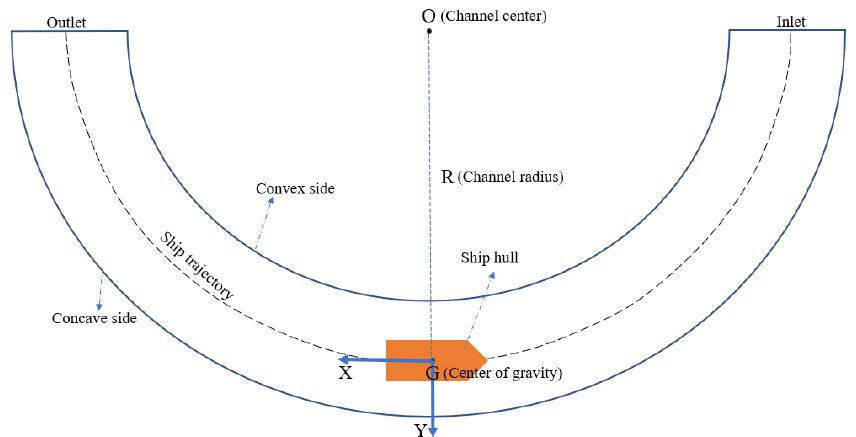
Figure 7. Plane figure of channel setting in this